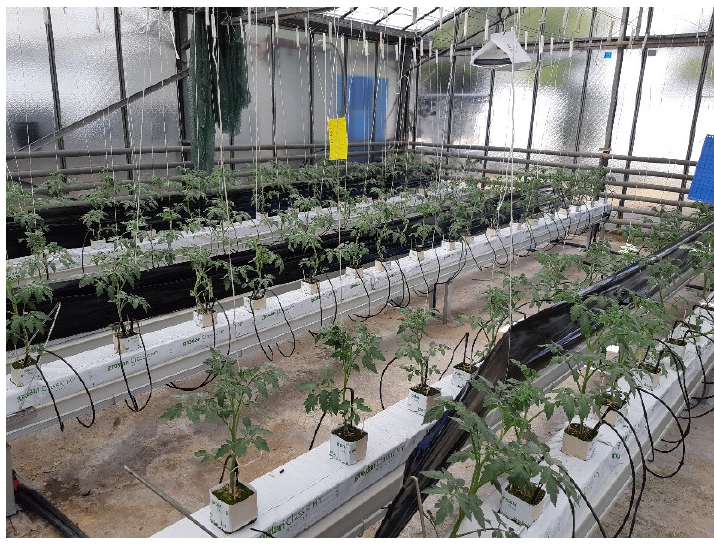
Figure 1. Tomato plants 17